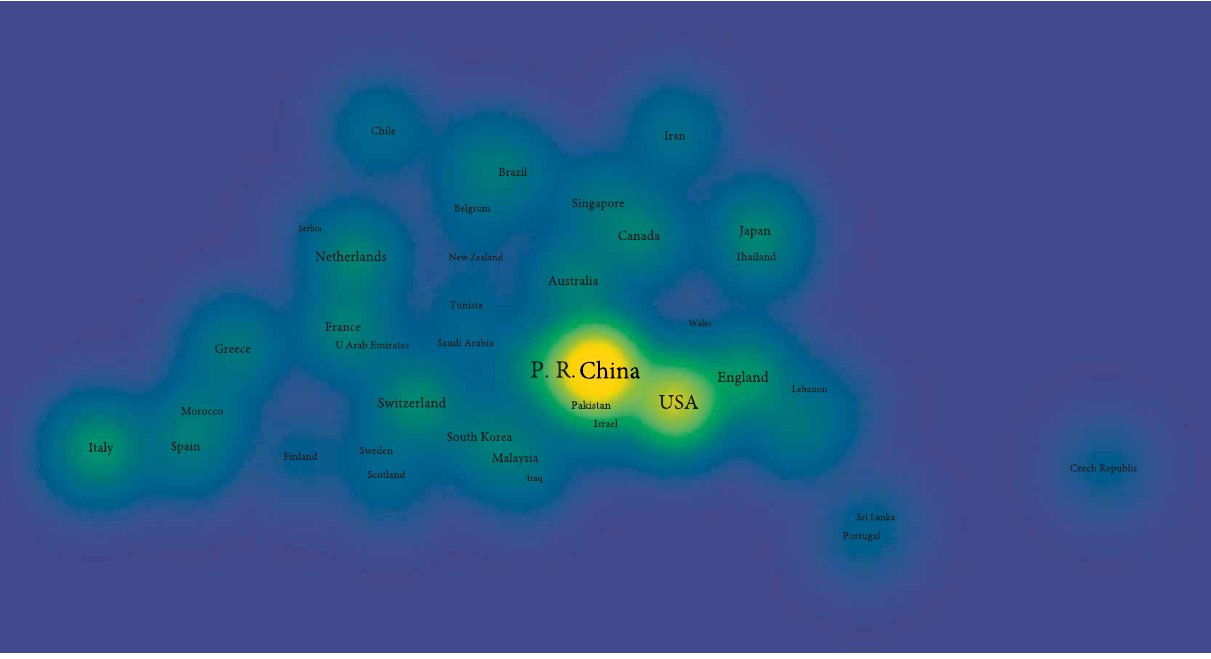
Figure 3: Collaboration network of gating control among authors and